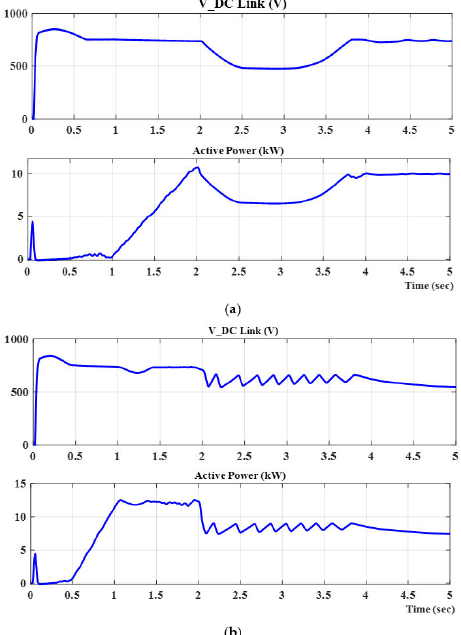
Figure 7. DC voltage and output active power with step change in radiation from 1000 to 800 W/m 2 at t = 1.2 s with: ( a ) conventional control and ( b ) proportional